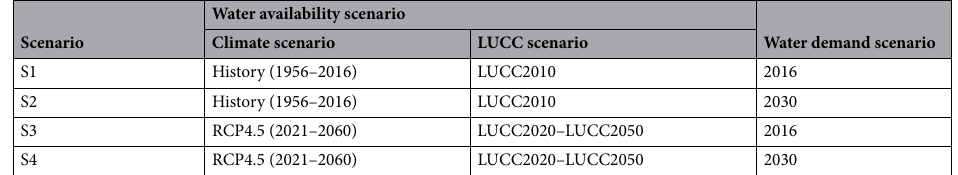
Table 4. The description of the four scenarios. S2–S4 are the future water availability change scenarios (climate change and LUCC simultaneously in the future): RCP4.5 (2021–2030) corresponds